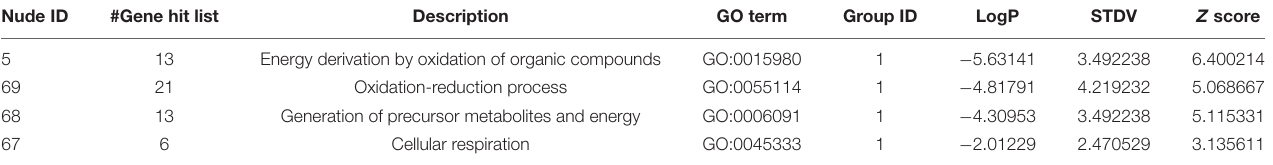
TABLE 3 | The information of the nudes clustered in Figure 3L